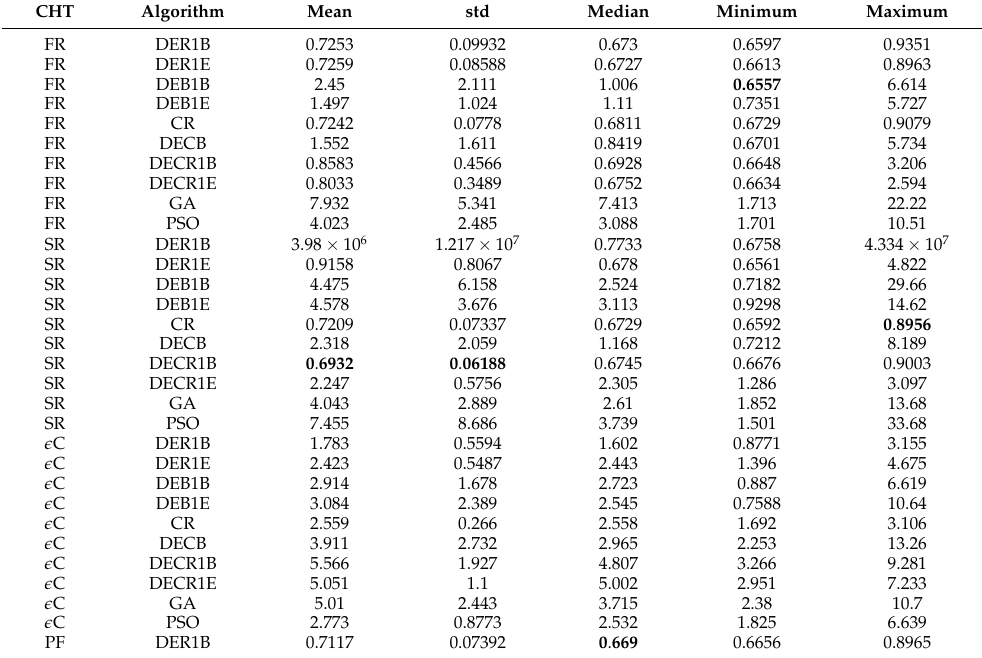
Table A8. Descriptive statistics of the overall performance for study case 2: Cam-linkage